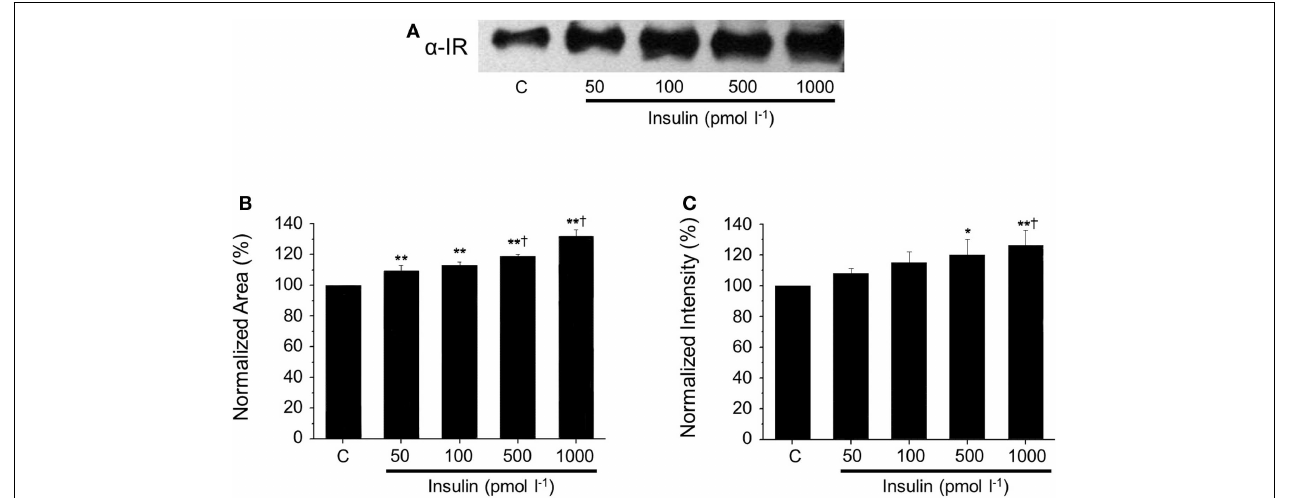
as the area or (C) the intensity of the bands obtained byWestern blot. Bars represent mean ± SEM of control and insulin-treated hepatocytes at 50, 100, 500, and 1000pmoll − 1 ( n = 3 each),* p < 0.05 and ** p < 0.01 for comparison with respect to control and † p < 0.05 with respect to the 50pmoll − 1 condition.